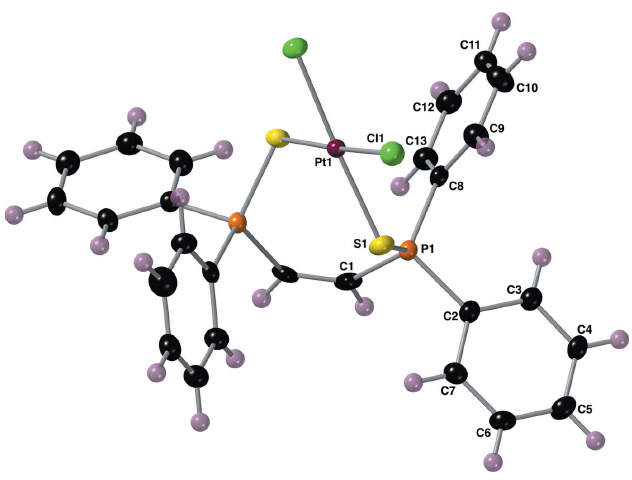
Figure 4 The complete molecular structure of compound II , with the atom-labeling scheme. Unlabeled atoms are related to labeled atoms by a crystal- lographic twofold axis. Displacement ellipsoids are drawn at the 40% probability level using standard CPK colors (Pt = maroon).